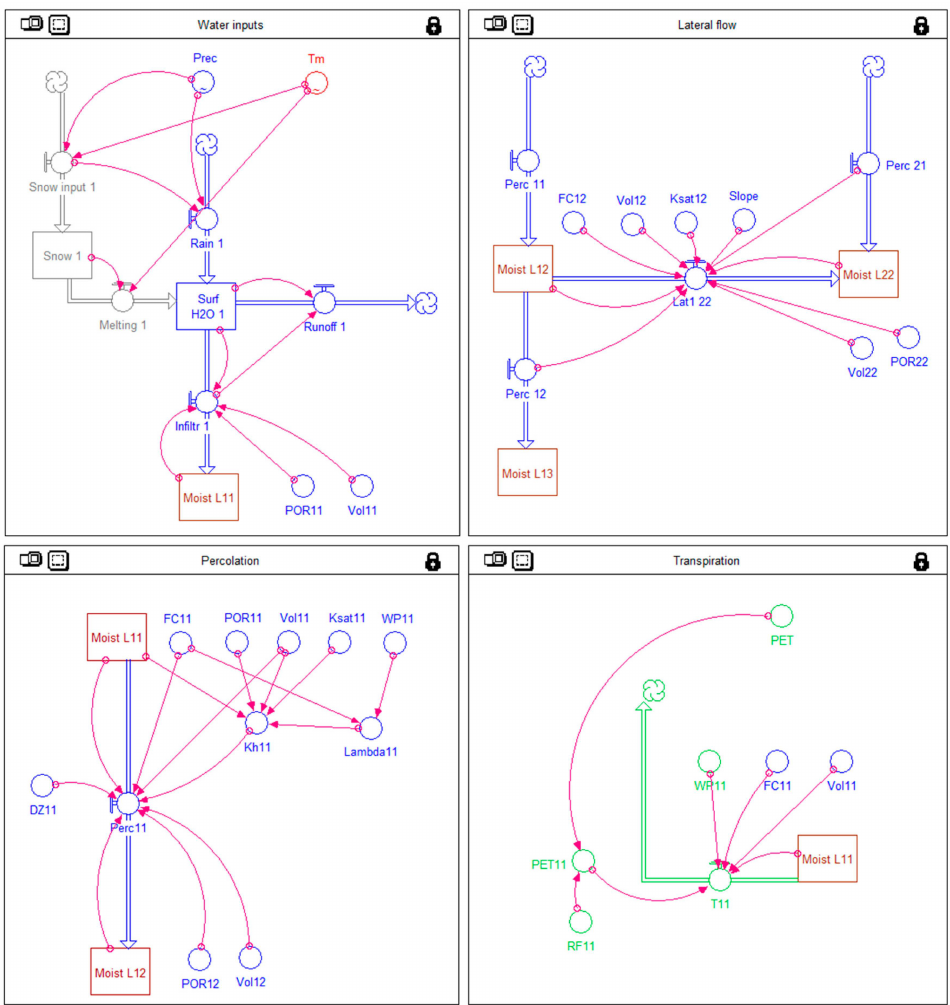
Figure 2. Illustration in STELLA of the main processes regulating water flows in the model: water inputs to the soil, percolation, lateral water flow and transpiration from a soil layer. The connectors (red arrows) indicate which factors are included in the calculation of the